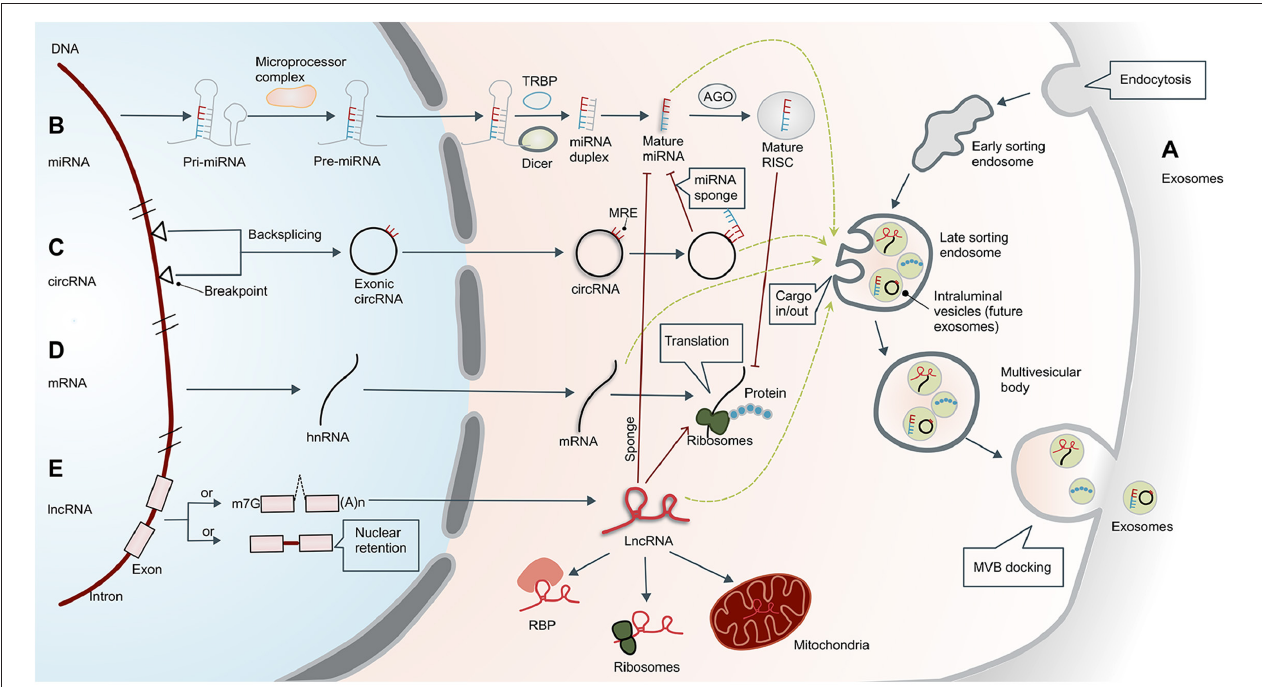
FIGURE 1 | Biogenesis of exosomes and non-coding RNAs. (A) Biogenesis of exosomes. Formation of exosomes begins with invagination of the plasma membrane. This process produces early sorting endosomes (ESEs) with cargos of what had been extracellular material. After cargos are transferred to and from other membranous structures, ESEs become late sorting endosomes (LSEs), whose secondary invagination forms intraluminal vesicles (ILVs—the future exosomes) that give rise to multivesicular bodies (MVBs). Finally, MVBs are transferred to and dock on the plasma membrane, resulting in release of the exosomes. The exosomes usually contain mRNA, proteins, and non-coding RNAs (ncRNAs), including microRNAs (miRNAs), circular RNAs (circRNAs), and long non-coding RNAs (lncRNAs). (B) Biogenesis and functional mechanism of microRNAs. Primary miRNAs (pri-miRNAs) are transcribed and cleaved by the microprocessor complex to form precursor miRNAs (pre-miRNAs). Pre-miRNAs are then transported into the cytoplasm and further processed by DICER or co-factors, including the trans-activation response RNA-binding protein (TRBP). Mature miRNAs in the cytoplasm are transported to the RNA-induced silencing complex (RISC), which can bind to the Argonaute (AGO) protein and ultimately guide the complex to the target mRNA. (C) Biogenesis of circular RNAs. Exonic circRNAs are formed by backsplicing the transcription products between two breakpoints on DNA. CircRNAs have a closed ring structure without a 5 ′ -end cap and a 3 ′ -end polyadenosine tail structure. In the cytoplasm, circRNAs can act as ceRNAs by sponging miRNAs with miRNA response elements (MREs), thereby reducing the inhibitory effect of the miRNAs. (D) Biogenesis of mRNAs. Translation of mRNA is the key regulatory target of ncRNA, which is separate from the regulatory effect of lncRNAs and miRNAs. The mRNAs can also enter exosomes. (E) Biogenesis of long non-coding RNAs. Unlike mRNA, many lncRNAs are processed incompletely and remain in the nucleus, while others are spliced efficiently and transported to the cytoplasm. In the cytoplasm, lncRNAs can interact with different types of RNA-binding proteins (RBPs) and ribosomes. In addition, lncRNAs are usually sorted into mitochondria or other organelles, including exosomes. They perform post-transcriptional functions by promoting/suppressing mRNA stability or sponging miRNA as competing endogenous RNAs (ceRNAs). m7G, 7-methyl guanosine 5 ′ cap; (A)n, poly(A) 3 ′